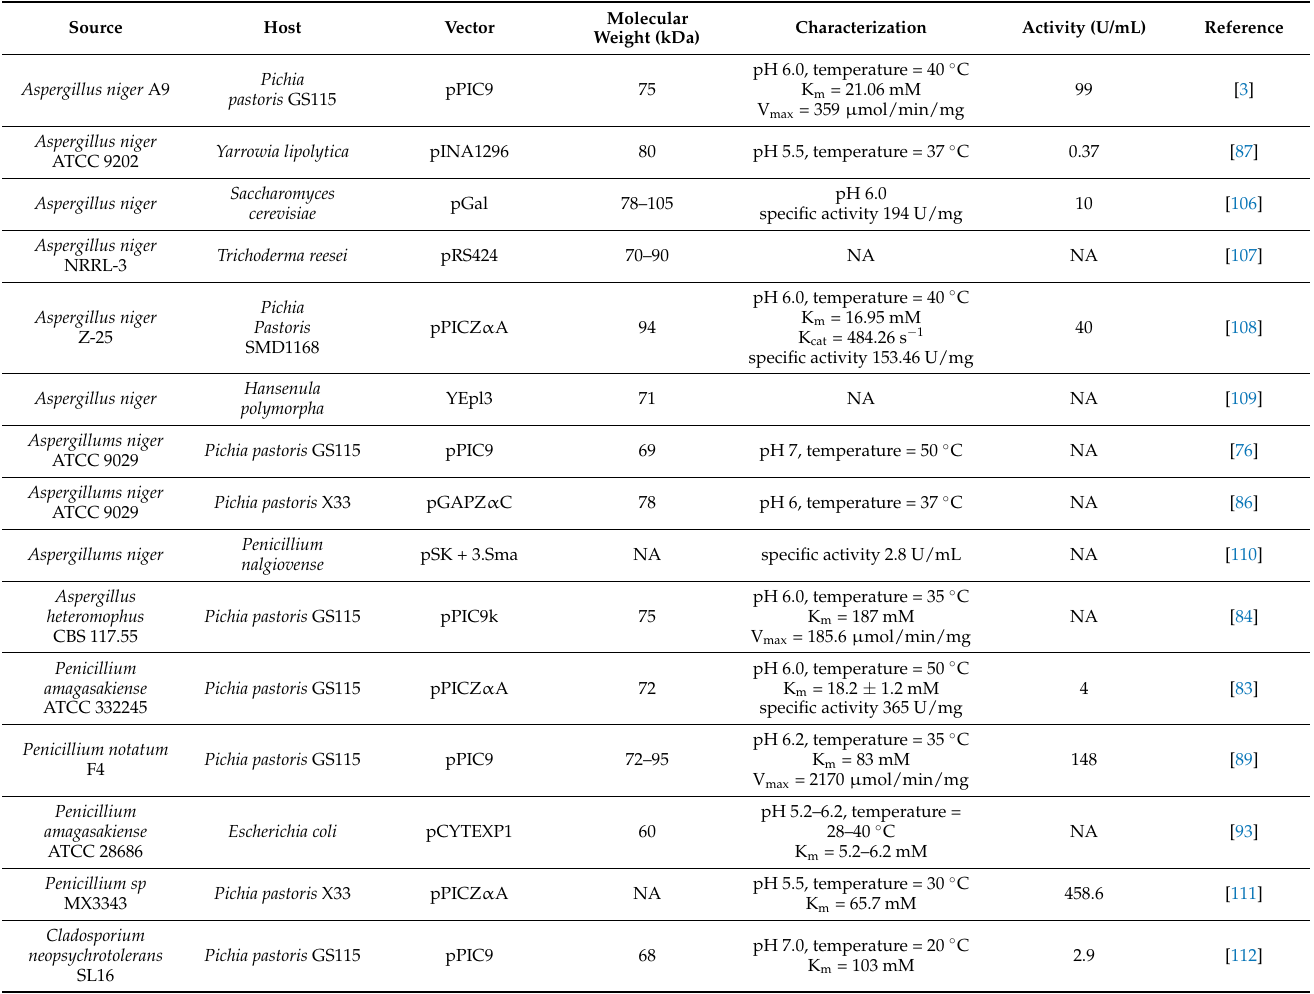
Table 2. Heterologous expression of glucose